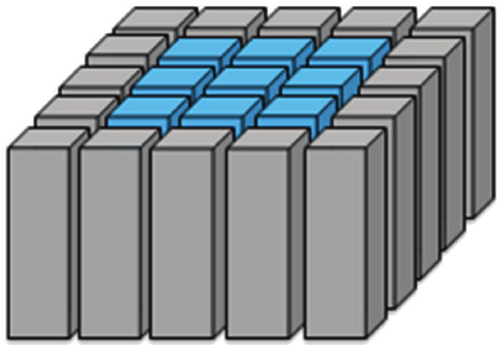
Figure 1: The distribution diagram for the 9 ingots used.